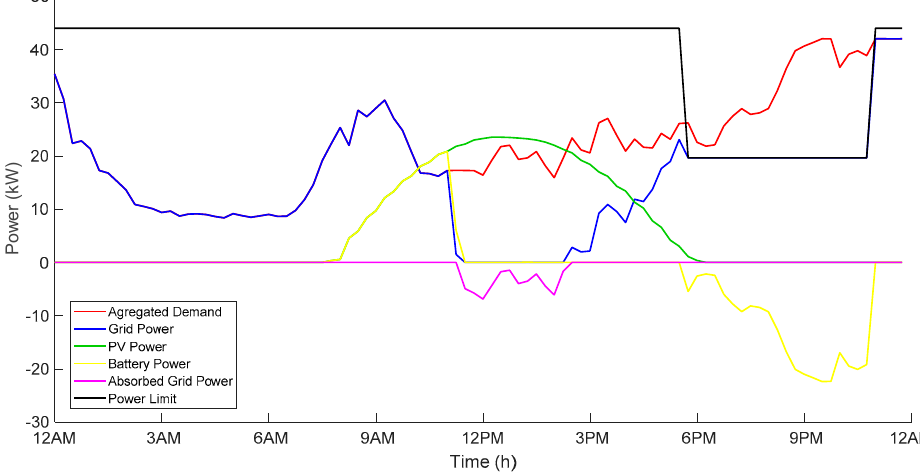
Figure 6. Sustainable Block Power flow with battery and hourly tariff.